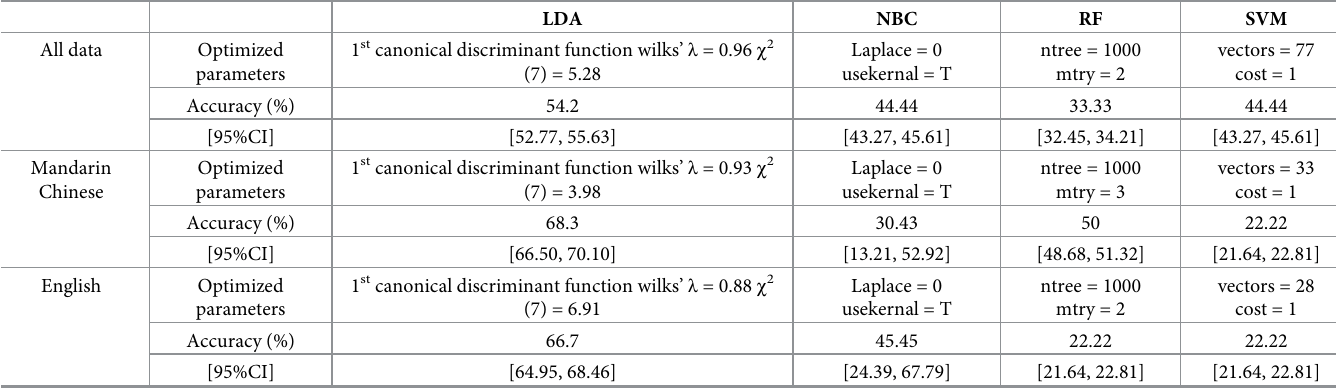
Table 3. Optimized parameters and accuracies of the automatic classification analyses on speech with and without face mask across language based on the four supervised learning algorithms [i.e., linear discriminant analysis (LDA), na ï ve bayes classifier (NBC), random forest (RF), and support vector machine (SVM)]. All seven acoustic parameters were included as the predictor variables.